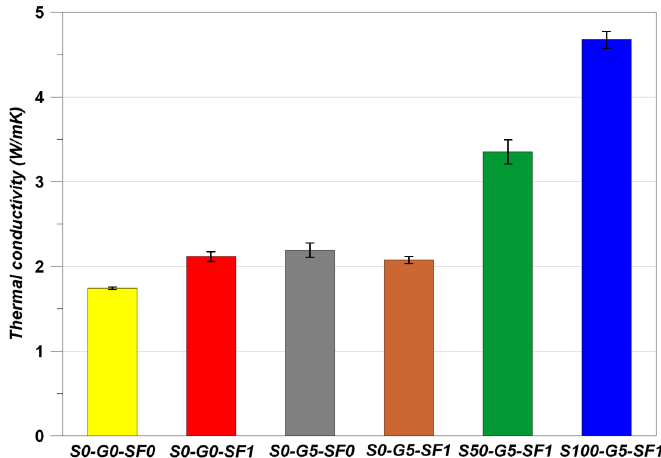
Figure 12. Thermal conductivity.